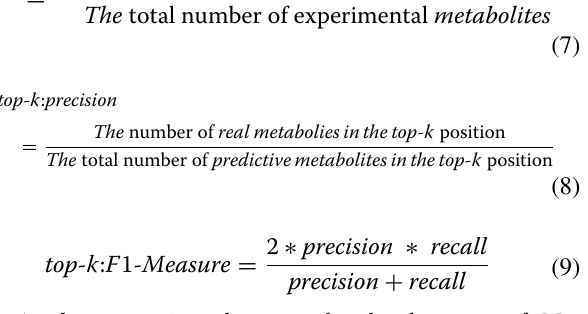
1, 3) position for all molecules in test set =